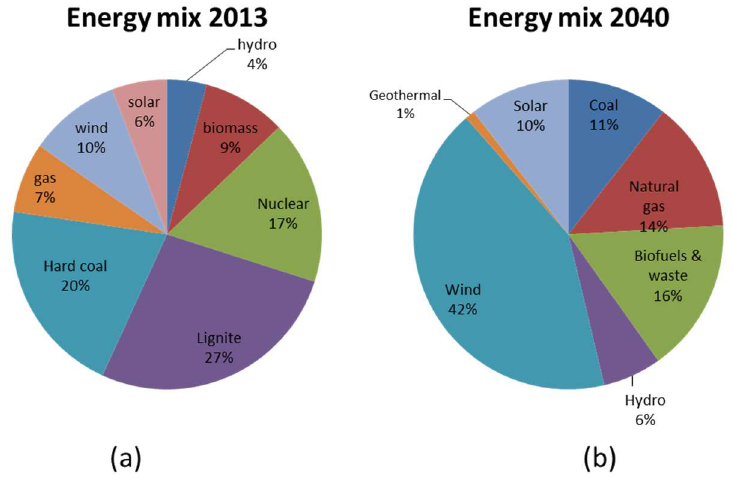
Figure 3. ( a ) Electricity mix for the 2013 baseline conditions [24], ( b ) Electricity mix for 2040 according to predictions from